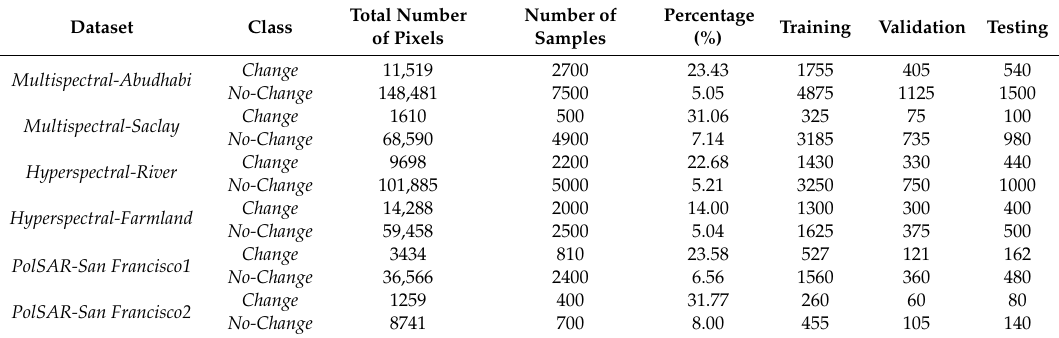
Table 6. Numbers of samples for change detection in the six datasets used in this study.